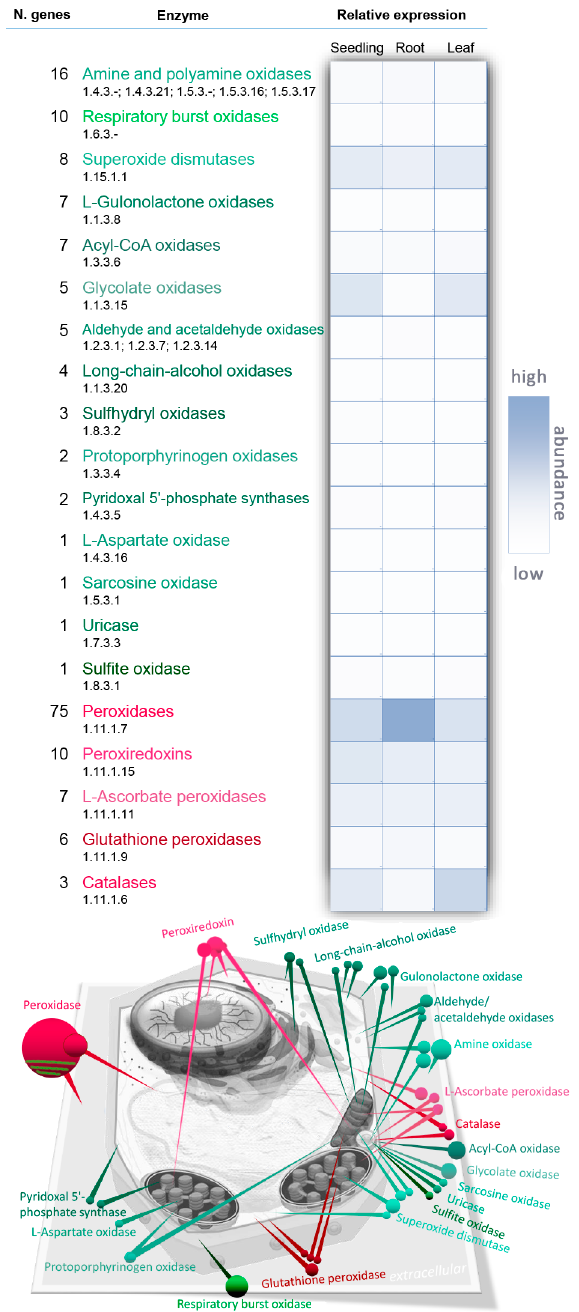
Figure 1. Key enzymes of hydrogen peroxide metabolism in plants. The list shows enzymes that directly catalyse hydrogen peroxide production or degradation in Arabidopsis , including the numbers of different isozymes, a comparison of relative gene expression profiles in seedlings, roots and shoots and the figure indicates subcellular localization. Colour coding: anabolic processes (green), catabolic processes (red), based on UniProt [16], SUBA 3.0 [17] and average gene expression profiles in 45, 24 and 7 NGS experiments for seedlings, leaf and root respectively (ThaleMine [18]).